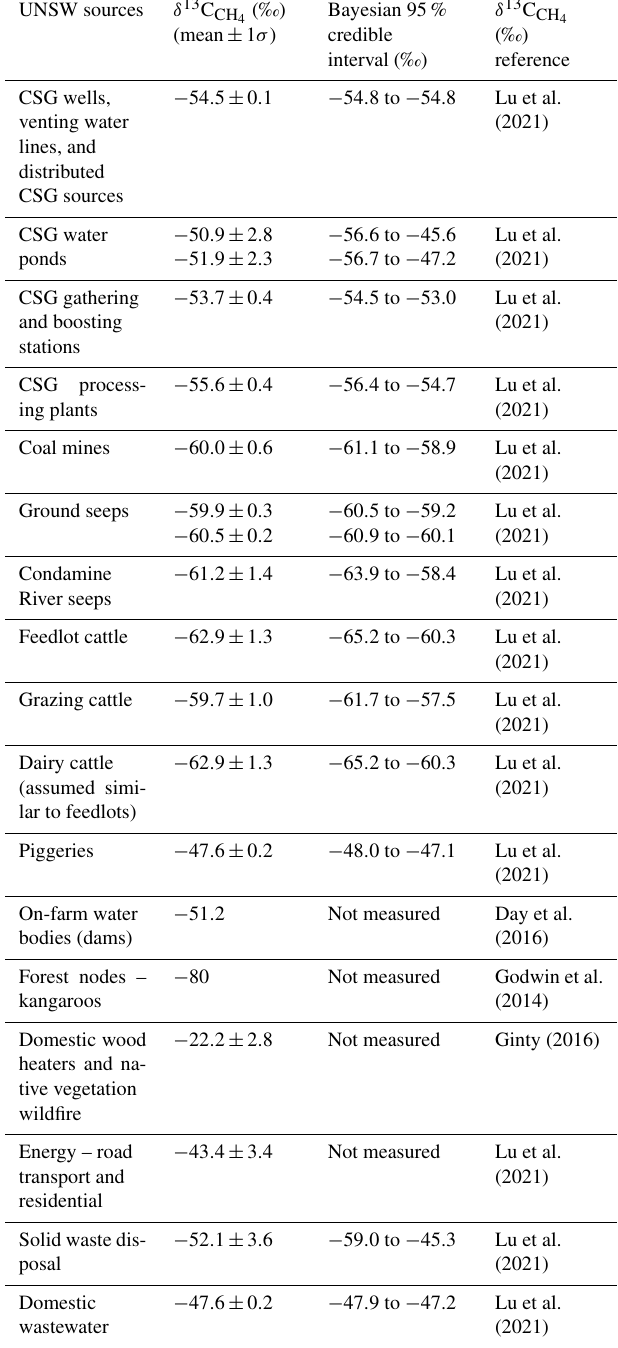
Table A1. Surat Basin ground-based campaign (Lu et al., 2021) and values for each source category within the study literature δ 13 C CH 4